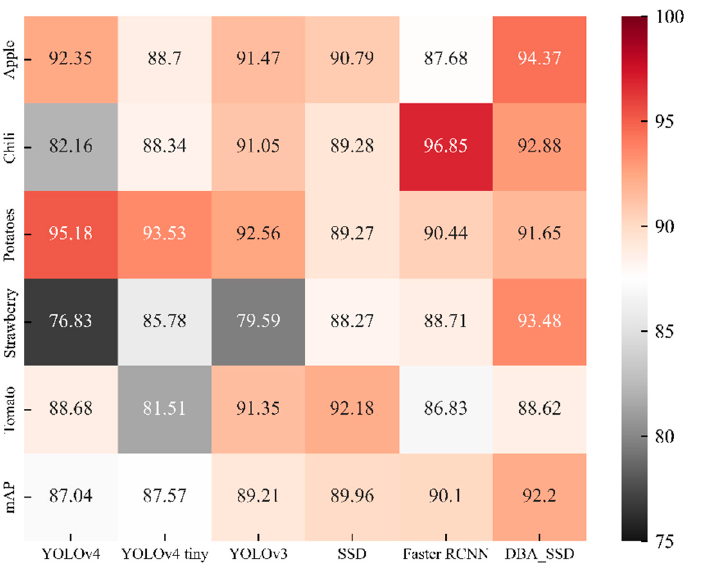
Figure 14. Heat map of correlation between different target detection algorithms and vegetable and fruit leaf types.